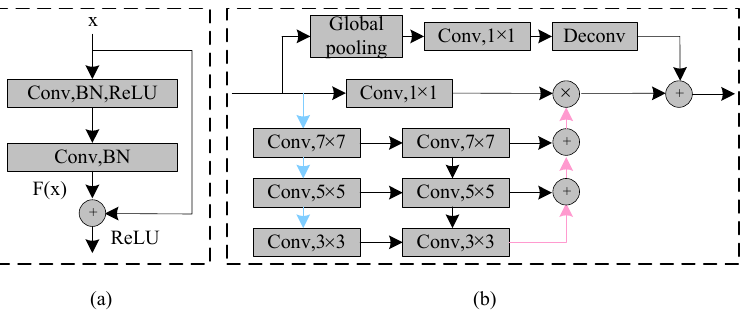
Figure 5. ( a ) Residual block. ( b ) Feature pyramid attention (FPA) module. The blue and pink lines represent the down-sample and upsample operators, respectively.